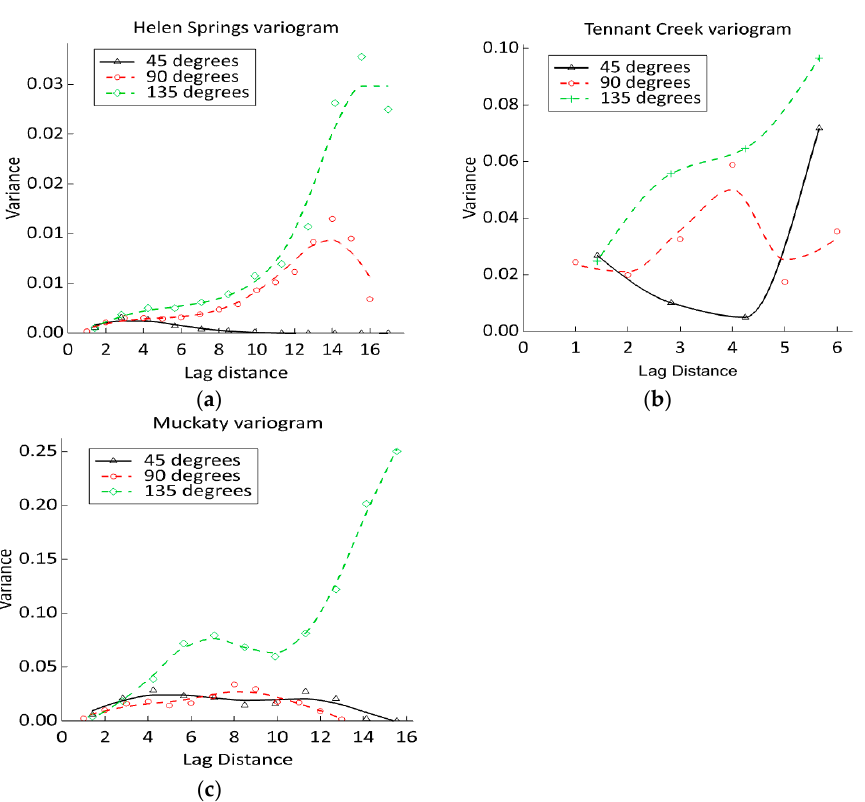
Figure 8. Exploratory semivariance distribution at study sites ( a ) HS, ( b ) TC and ( c ) MU in three compass directions, NE, E, and SE, showing that there was pronounced spatial autocorrelation in population distribution along the 135° and, to a lesser extent, 90° compass directions at all sites. Spatial autocorrelation could not be discerned for the 45° compass direction. Autocorrelation was much more pronounced in HS and MU sites that are both flat with low vegetation.